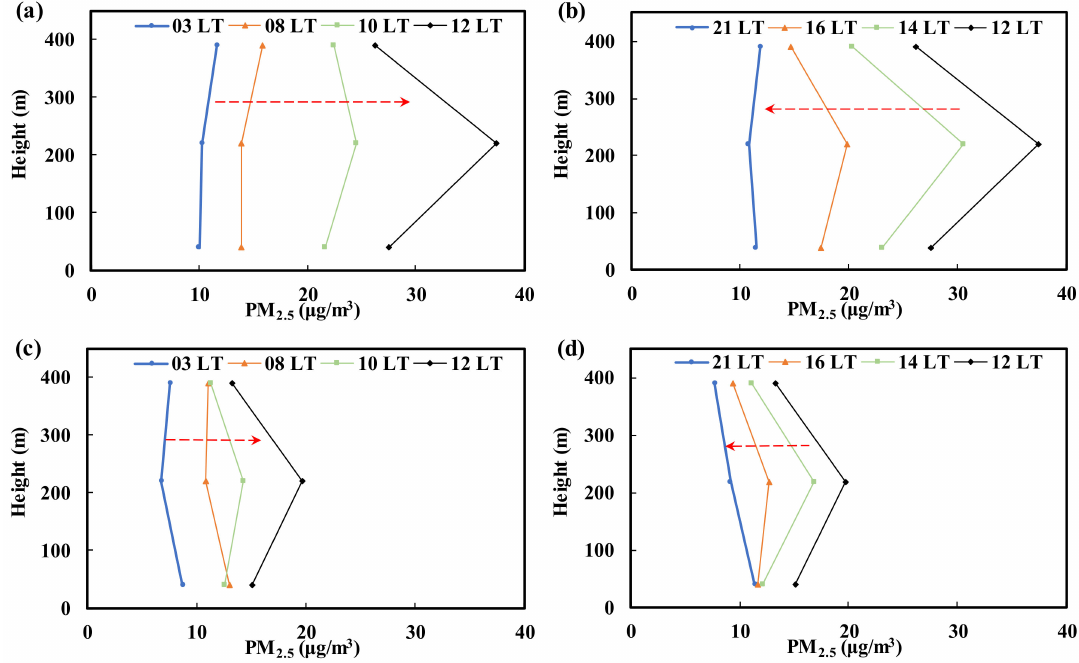
Figure 10. Analysis of the PM 2.5 vertical concentration profiles at different time points. ( a , b ) Episode days; ( c , d ) Sampling